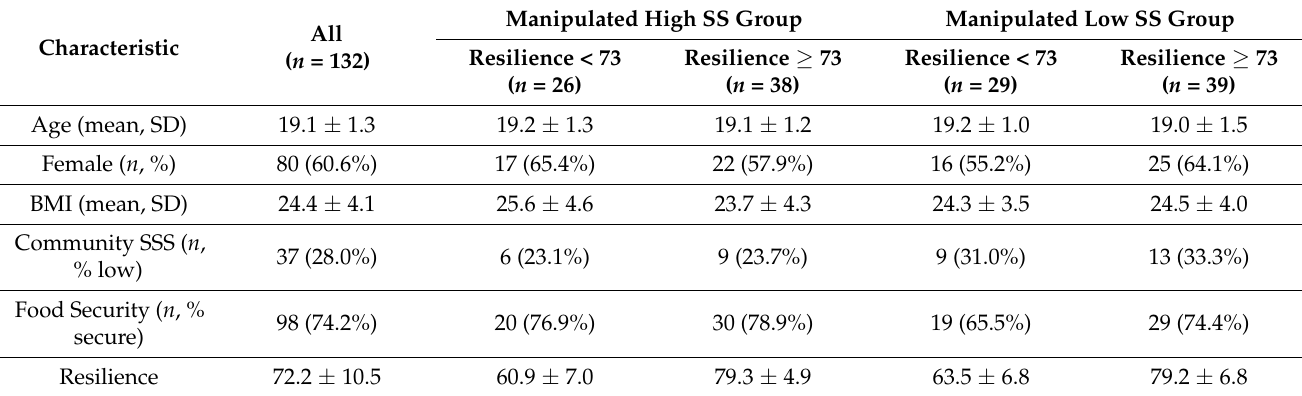
Table 1. Demographics by social status (SS) condition and resilience level at